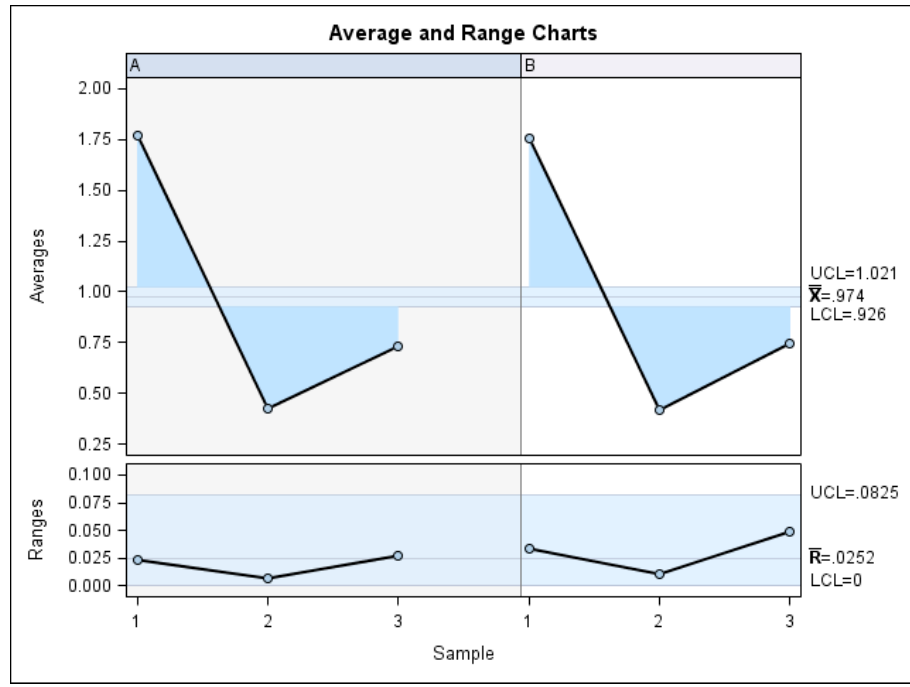
Figure 12. Charts for the average of the two measurements of the cement volume remaining after fixed lingual multibracket therapy debonding (1), the cement volume remaining after clearing the excess cement (2), and the enamel volume removed after cement clearance, (3) performed by each operator (average), as well as the differences in the two measurements of the three volume parameters determined by each operator (ranges).